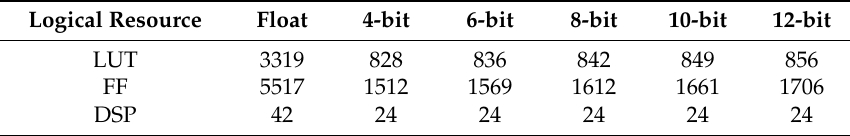
Table 2. Logical resource consumptions of fused-layer PEs in six formats.